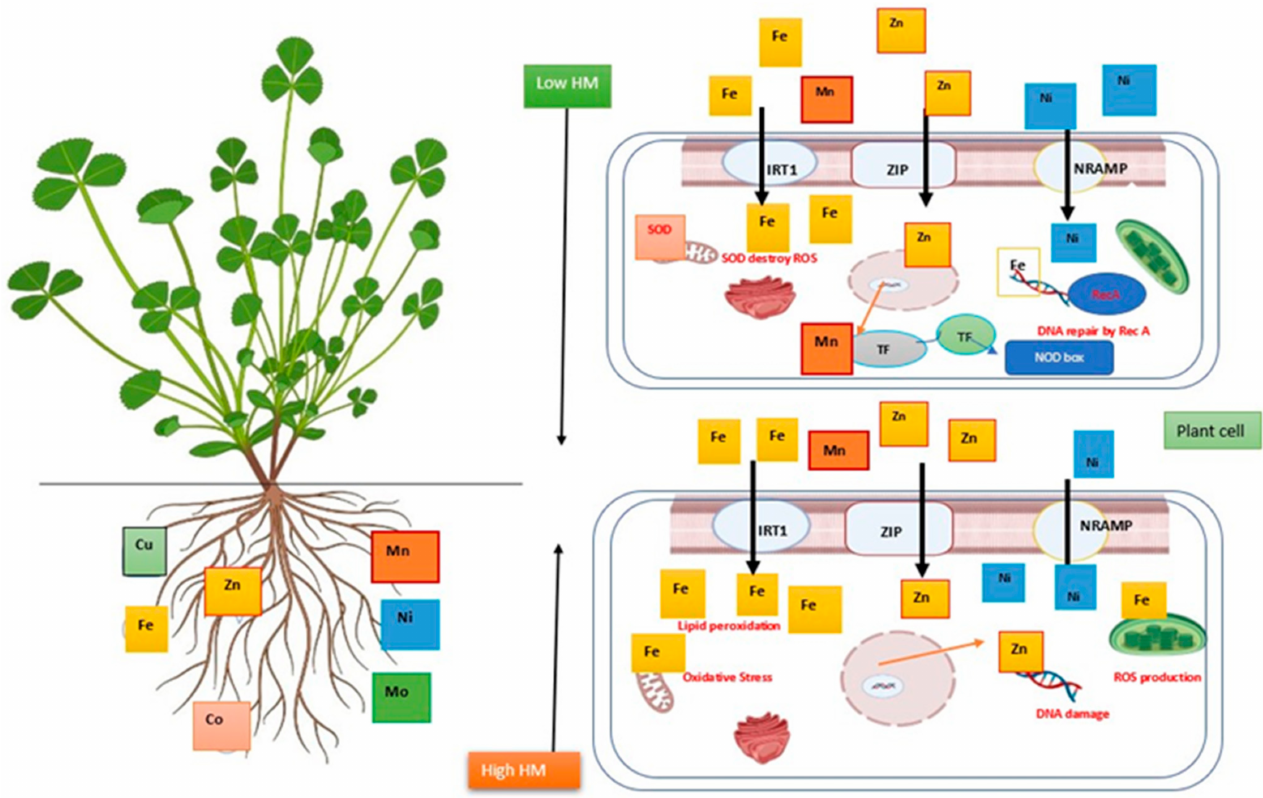
Figure 1. Impact of heavy metals’ contribution to the creation of proteins, nucleic acids, photosyn- thesis pigments, and cell membrane function and structure at low concentrations [50]. Mn enhances antioxidant capacity [51], while Fe increases N 2 -fixation and DNA repair [52]. At high concentra- tions, it causes conversion of numerous significant functional groups, lipid peroxidation (LPO), mitochondrial dysfunction, ROS production, and biochemical disruption via changing enzymatic activity